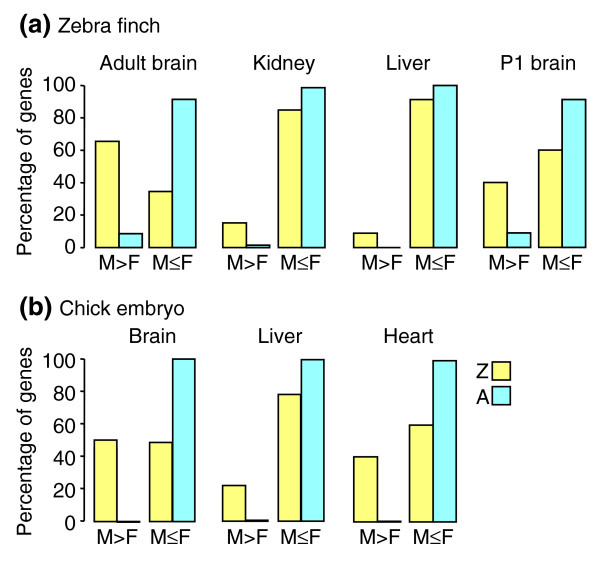
Comparison of male and female gene expression in birds. The bar graphs compare the percentages of Z (yellow) and A (blue) genes that are expressed at significantly higher levels in males vs females (M > F) or are expressed equally or more highly in females (M ≤ F). Four tissues are shown for zebra finch (a) and three for chick embryo (b). In all tissues, a significantly greater proportion of Z-linked genes, relative to A genes, were expressed at higher levels in males than females.